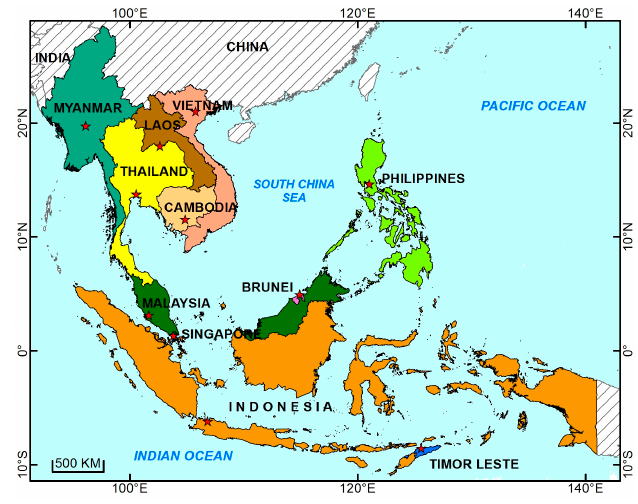
Figure 1. An overview of the Southeast Asia.